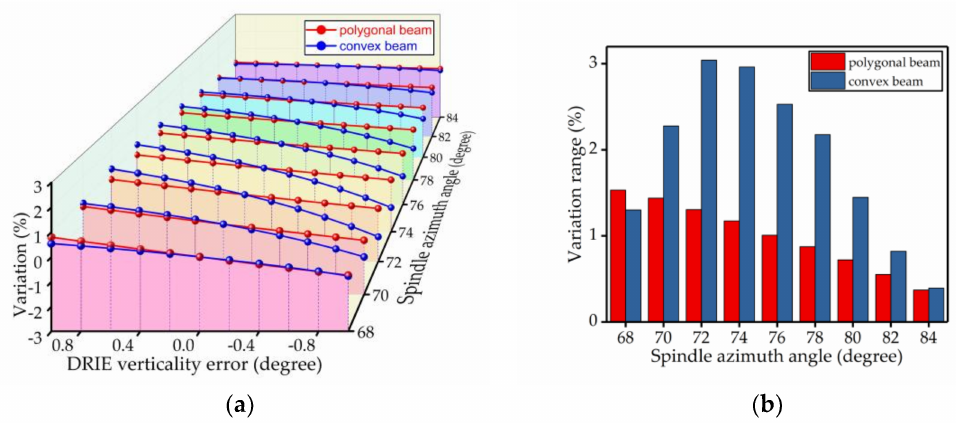
Figure 14. Influence of the DRIE verticality error on the spindle azimuth angle of the polygonal cross-section beam and convex cross-section beam; ( a ) shows the relationship between spindle azimuth angle variation and DRIE verticality error; ( b ) shows the range of variation—the value is the difference between the maximum and minimum values of each